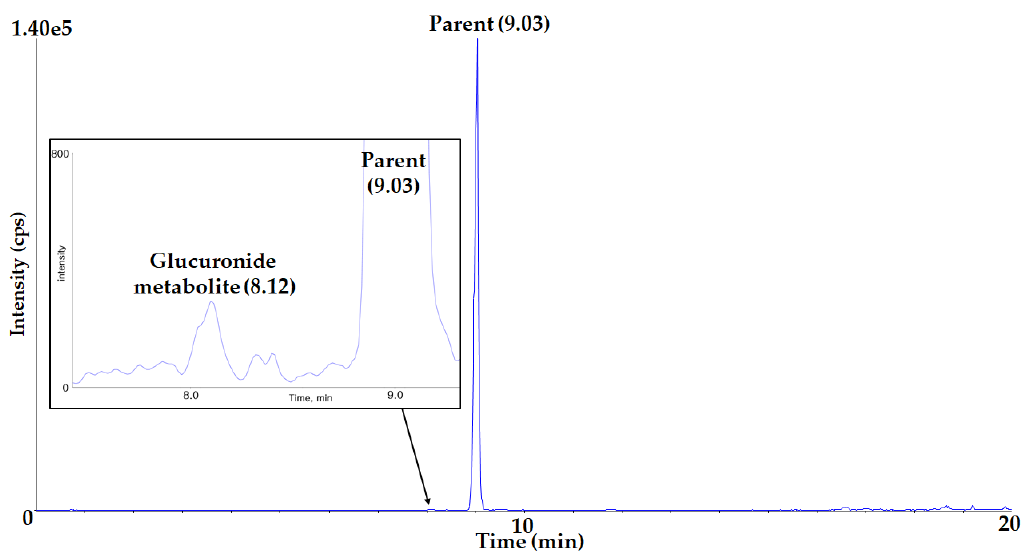
Figure 9. Total ion chromatograms of α -amanitin and its glucuronide metabolite in liver micro ‐ somes.